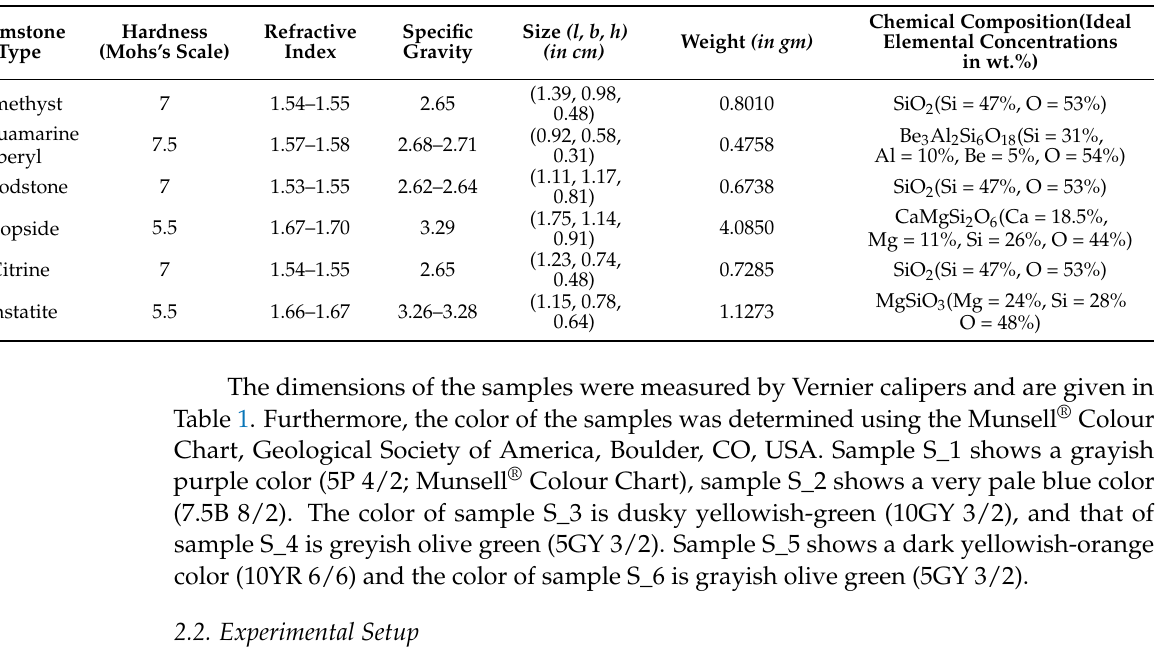
Table 1. Characteristics of the gemstone